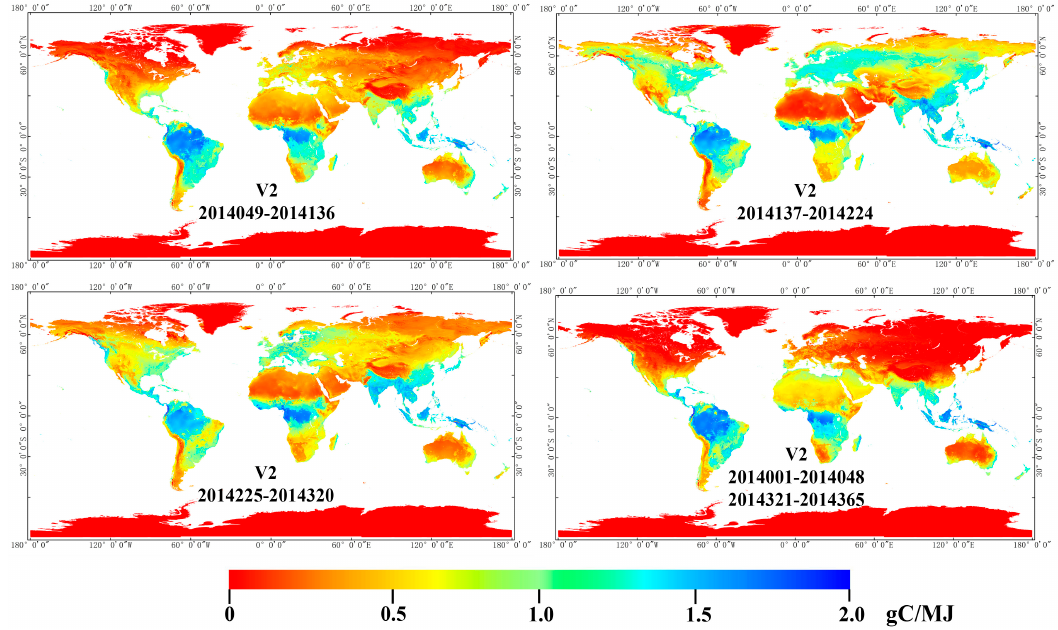
Figure 6. The distributions of LUE by the parameterization approach with the CI (V2).